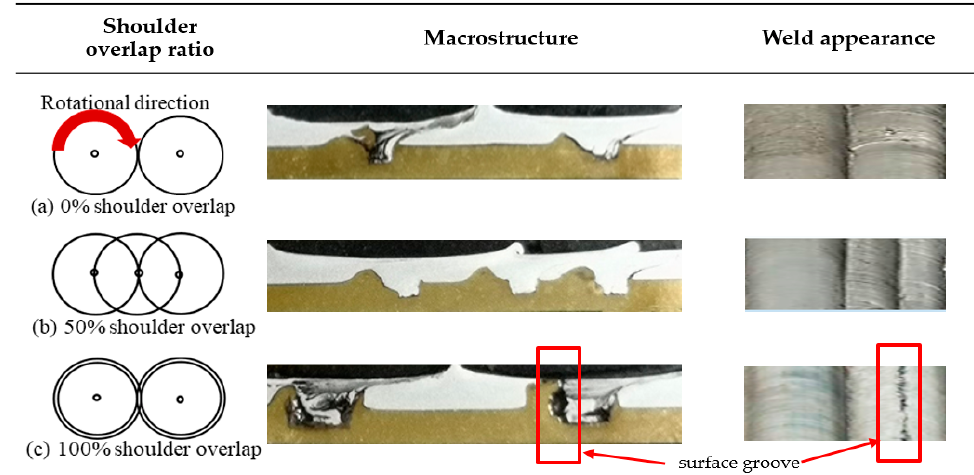
Figure 9. Influence of shoulder overlap ratio at Al–Cu clad joined.